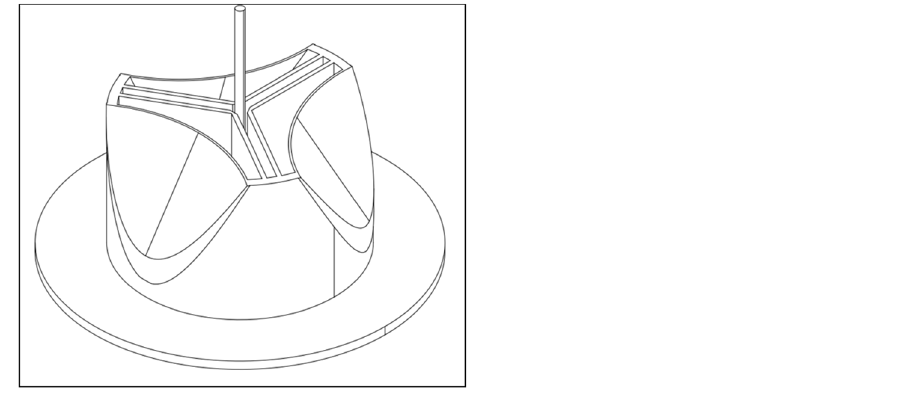
Figure 5. Potential insertion of TAVI guidewire through the central structure of prototype C5.